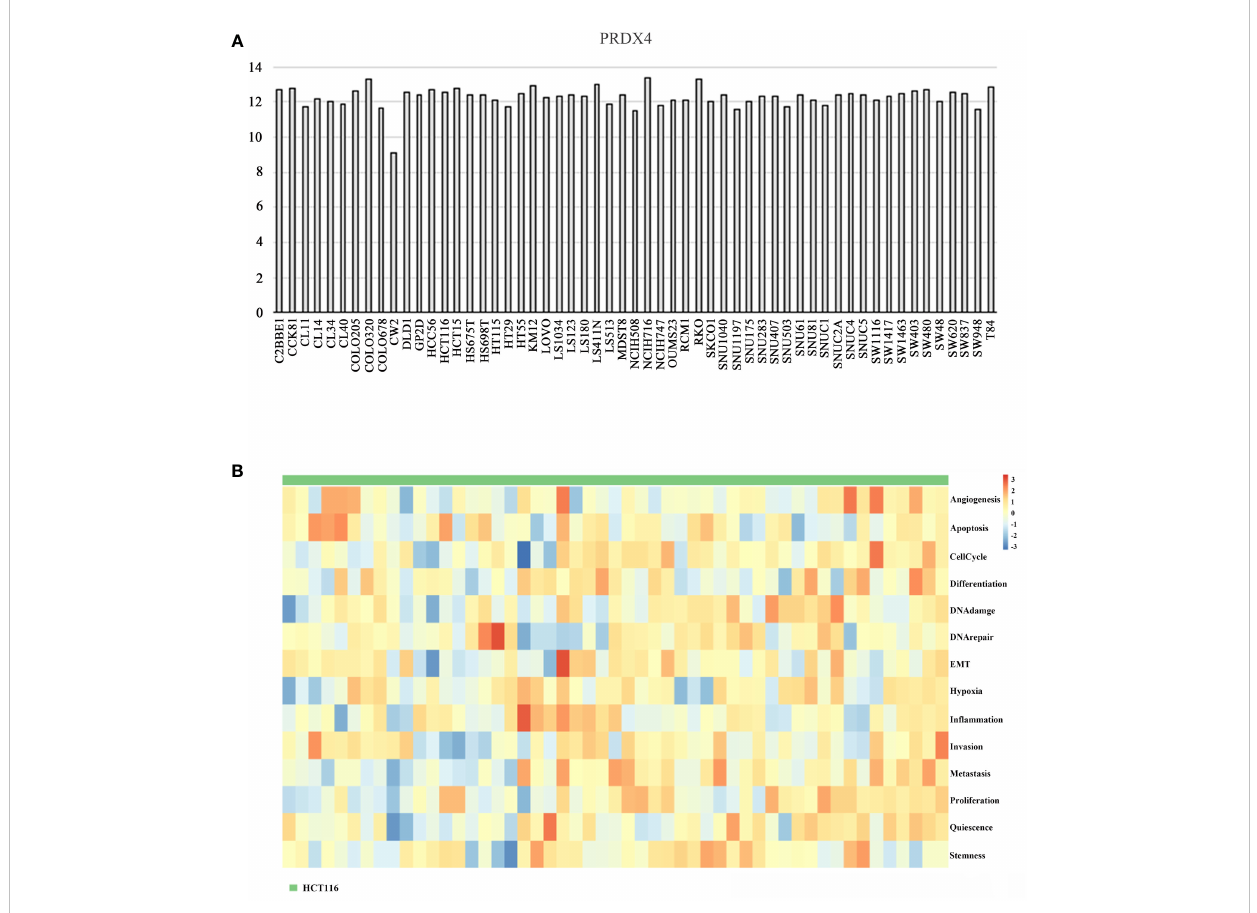
FIGURE 11 Differential expression of PRDX4 in different CRC cell lines (CCLE and cancerSEA). (A) The mRNA expression level of PRDX4 in various CRC cell lines, as determined by CCLE analysis. (B) The heatmap in this panel displays the activity of function states of cells in the selected dataset. Rows represent function states, columns represent hierarchically clustered cells. Column labels indicates the cell groups which cells belong to. CCLE, cancer cell line